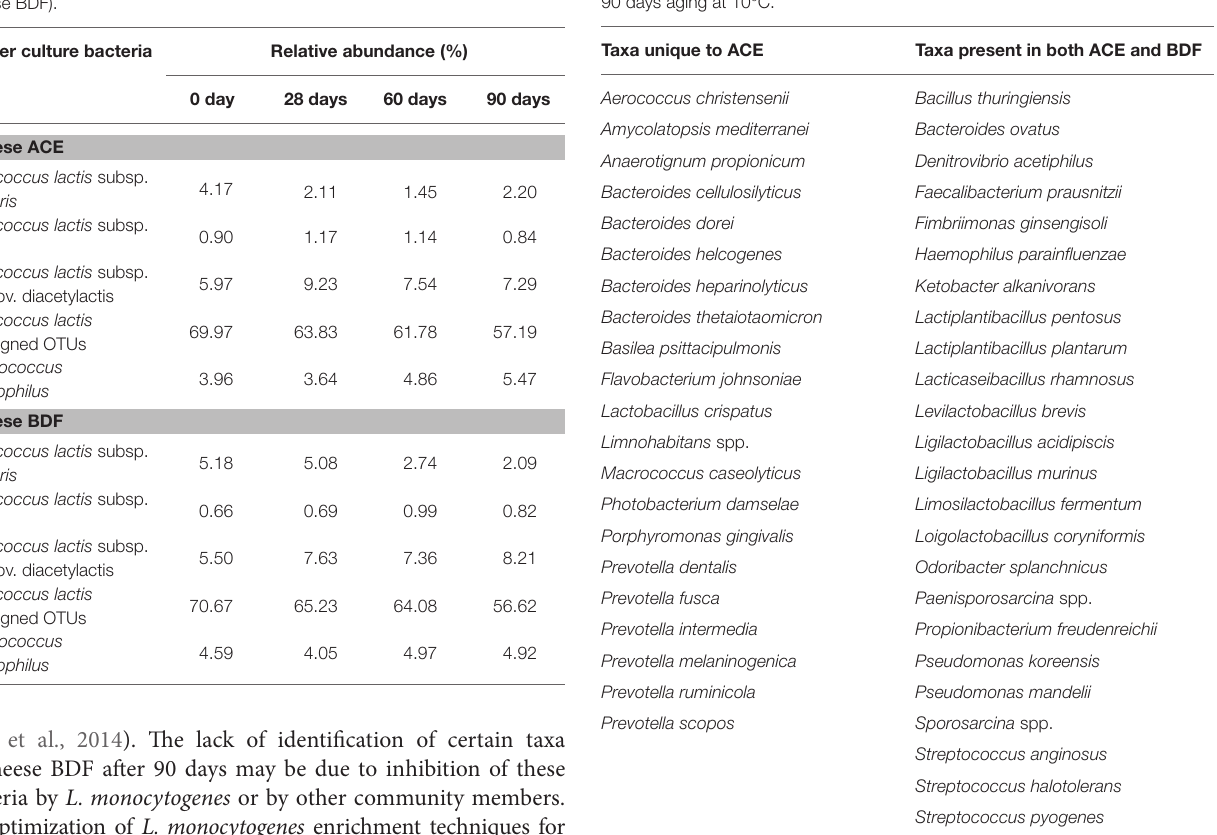
TABLE 5 | Taxa present at relative abundances of 0.1–0.5% in Gouda cheese manufactured with unpasteurized milk (cheese ACE) or with unpasteurized milk